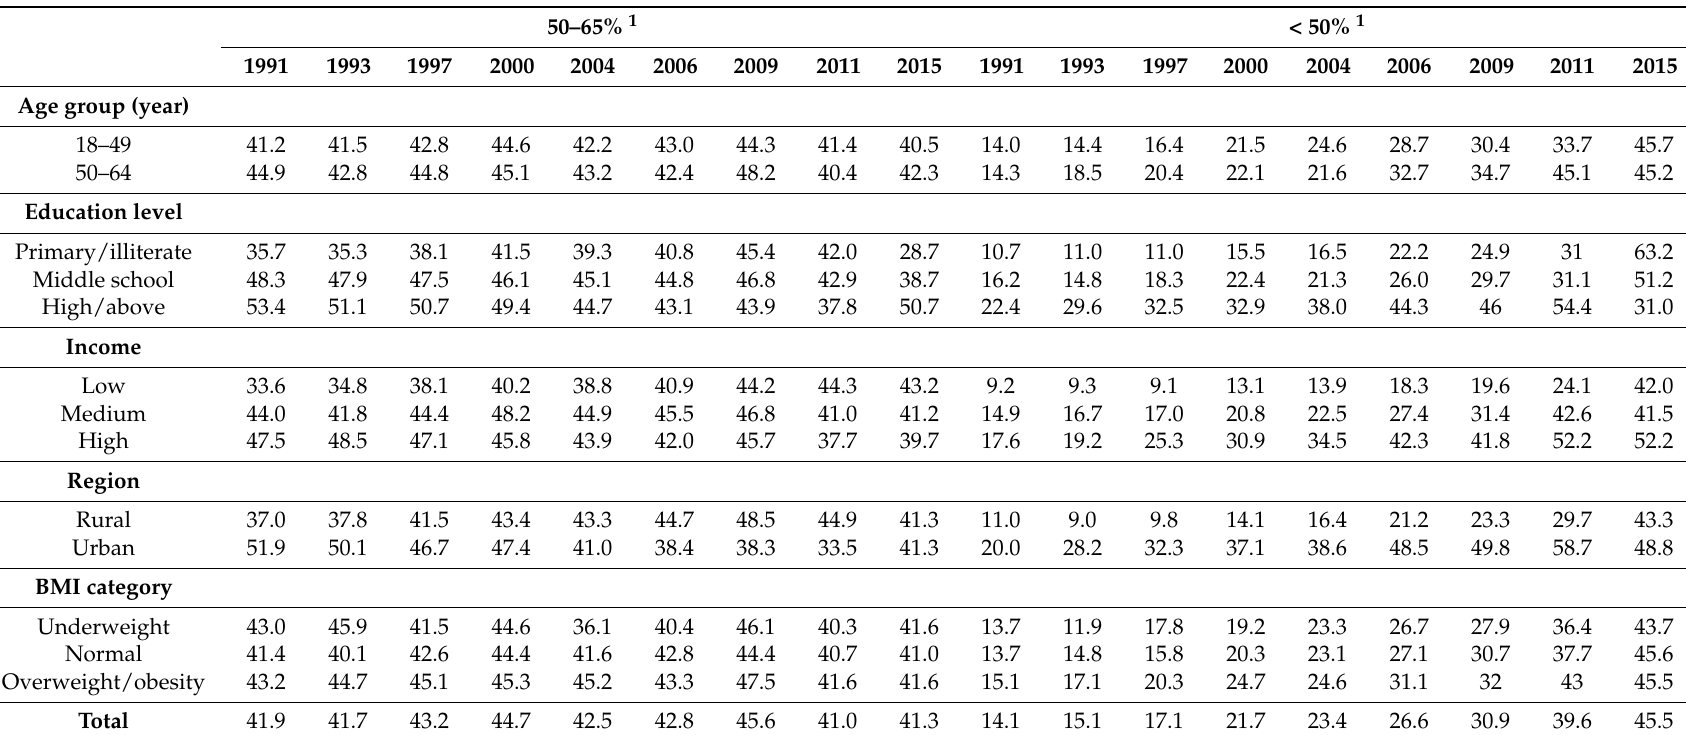
Table A2. Energy from carbohydrate compare to the DRIs standard in Chinese female adults from 1991 to 2015 2